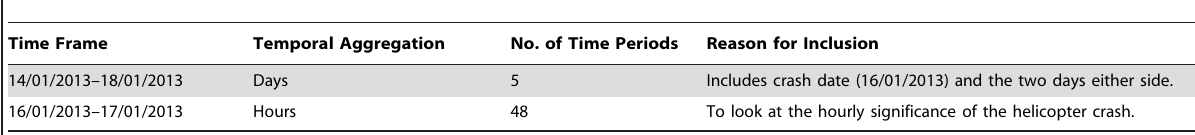
Table 1. The two temporal aggregations used during space-time scan statistics.